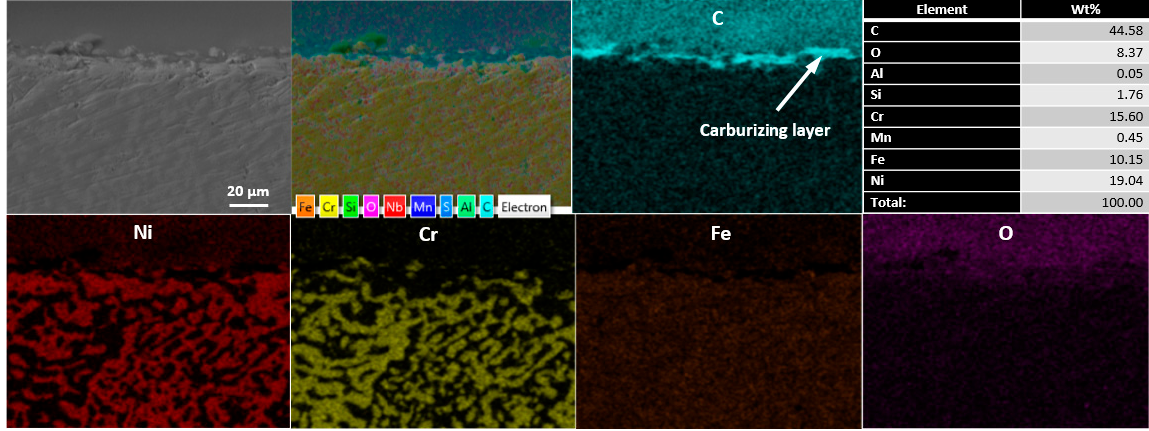
Figure 3. Cross-sectional SEM image and chemical composition mapping of the carburized KHR 45A steel subjected to UNSM treatment.